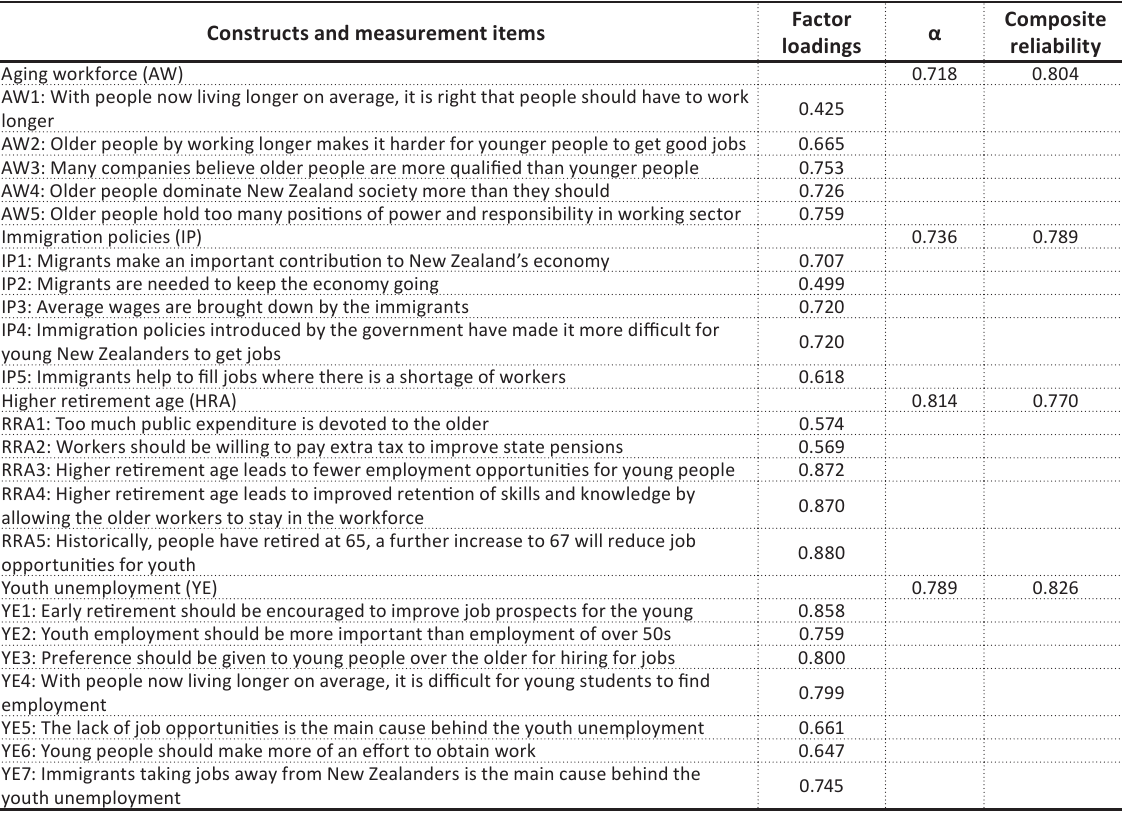
Table 1. Measurement items, factor loadings, Cronbach’s alpha, and composite reliability Constructs and measurement